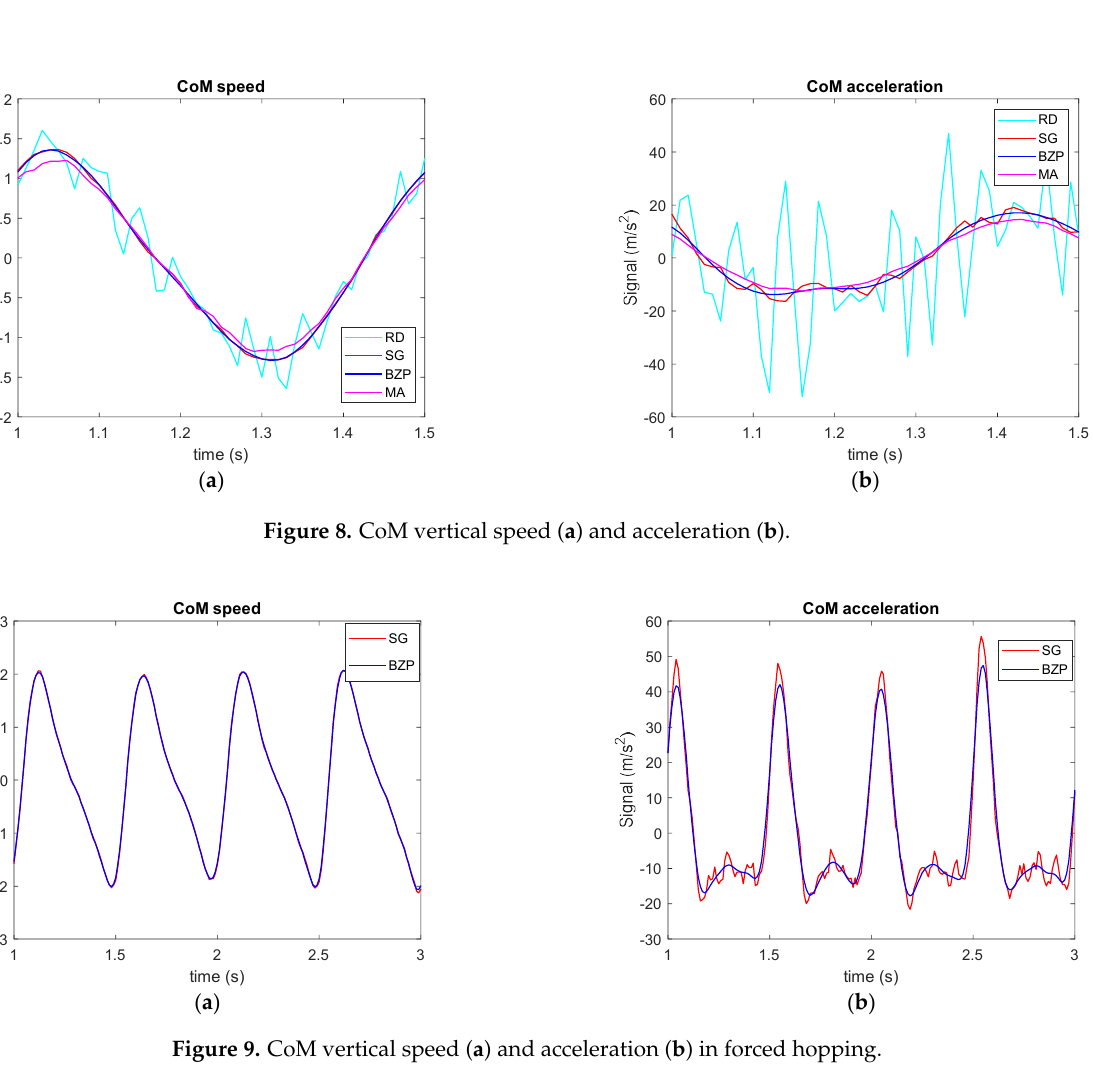
( b ) Figure 7. CoM vertical position during hopping. Complete acquisition ( a ) and detail ( b ).